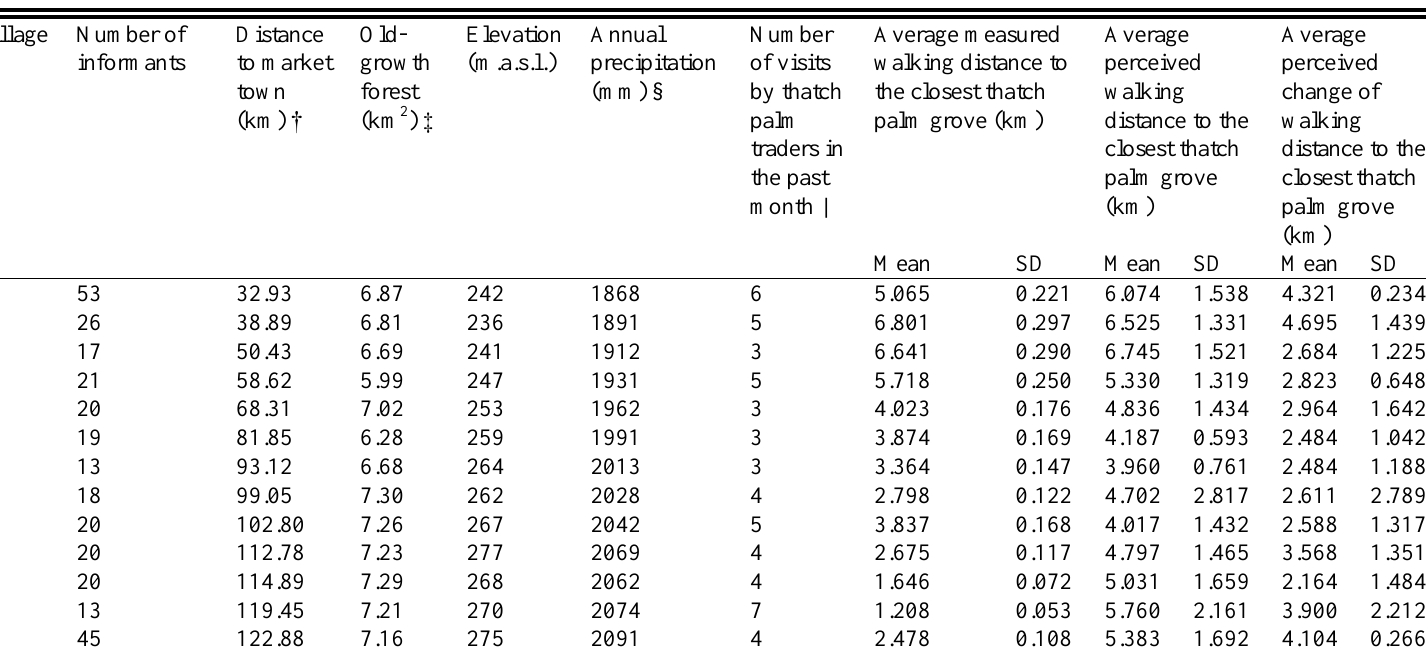
Appendix 2. List of villages sampled and corresponding characteristics along the Tsimane’ Territory, Bolivian